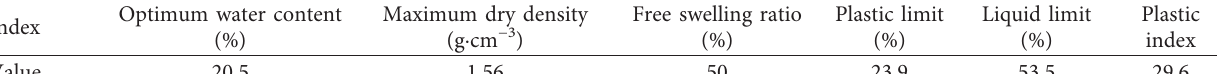
Table 1: Basic parameters of the test soil.